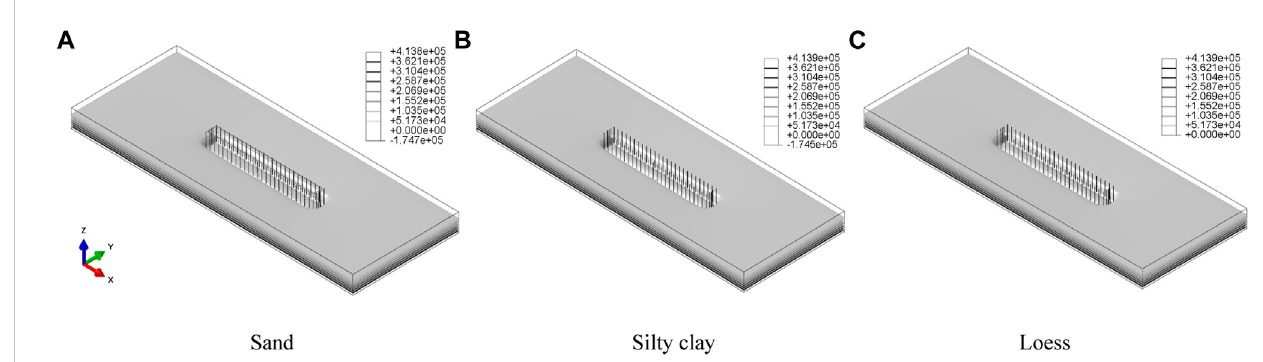
FIGURE 4 Isosurface contour of pore pressure after dewatering (Unit: Pa) (A) Sand (B) Silty clay (C) Loess.